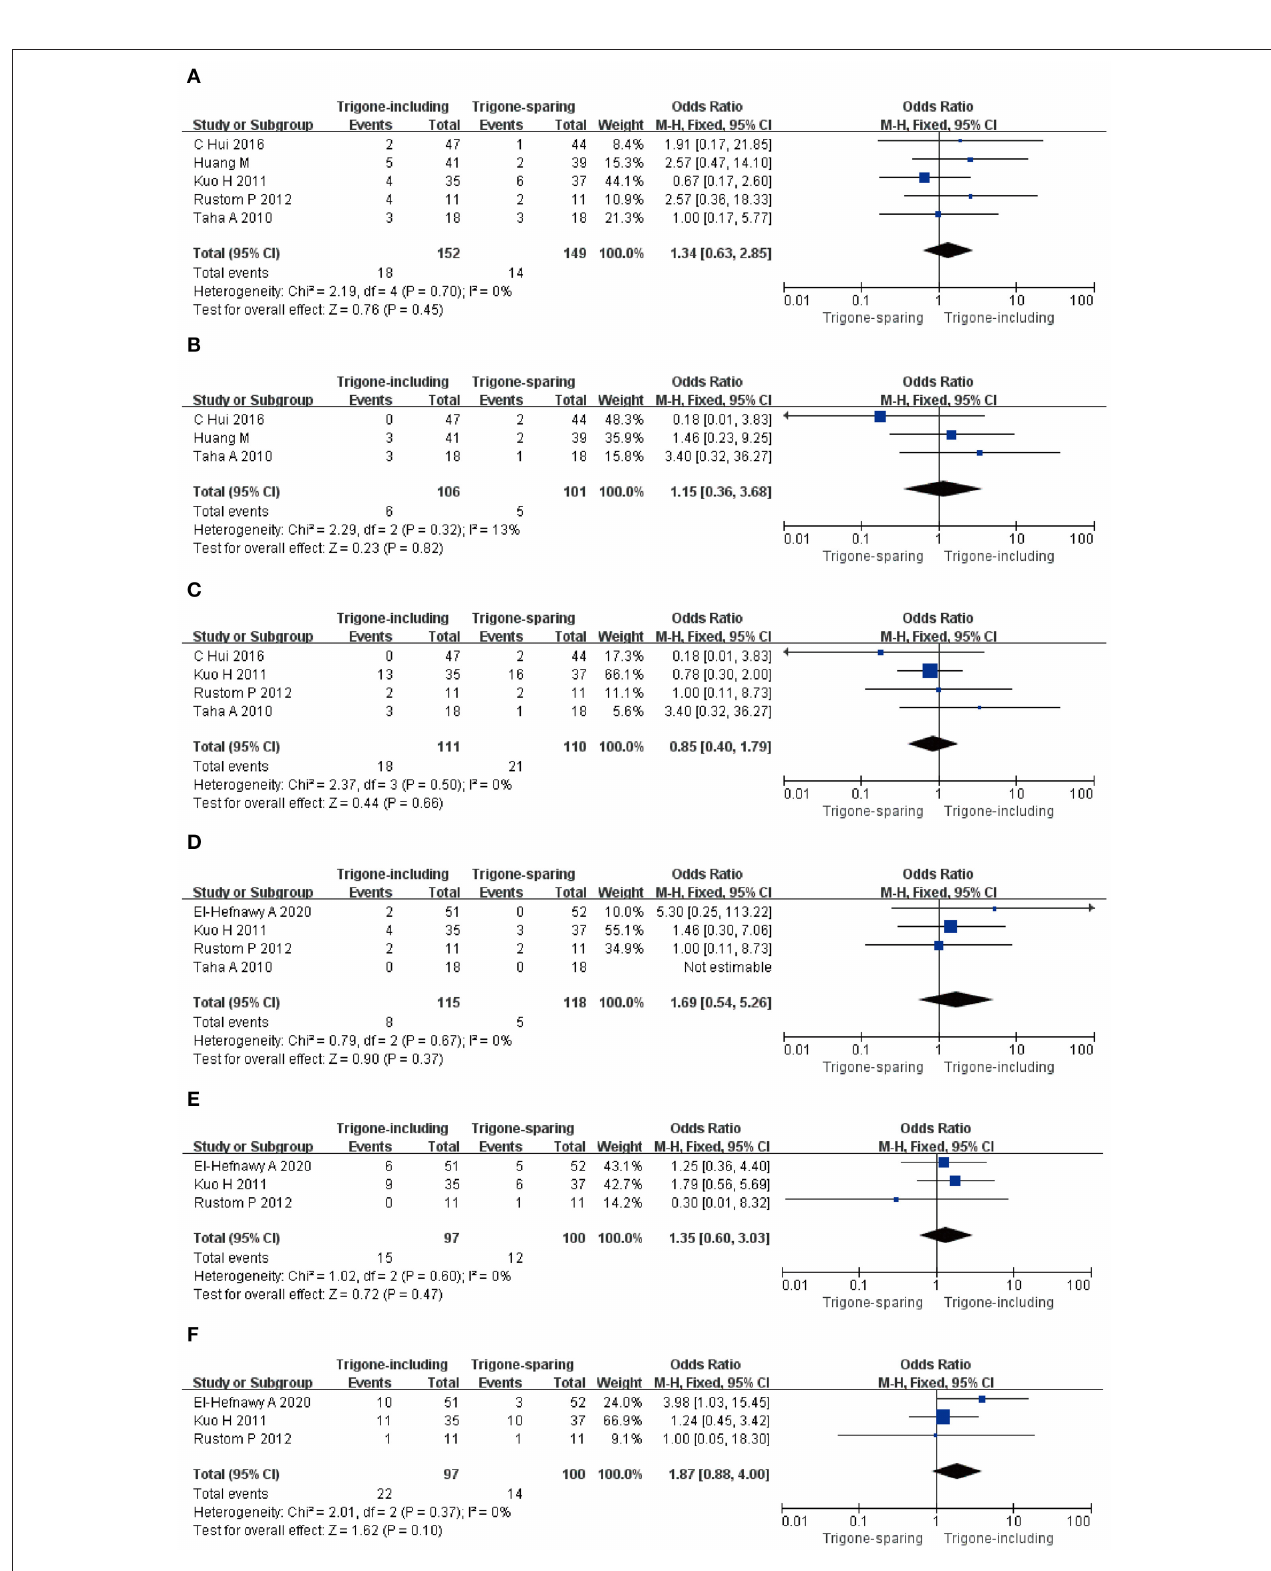
FIGURE 6 | Forest plots showing changes between two groups in (A) hematuria, (B) general weakness, (C) bladder discomfort, (D) incidence of large post-void residual, (E) urinary tract infection, and (F) difficulty of voiding; SD, standard deviation; IV, inverse variance; CI, confidence interval; df, degrees of freedom.